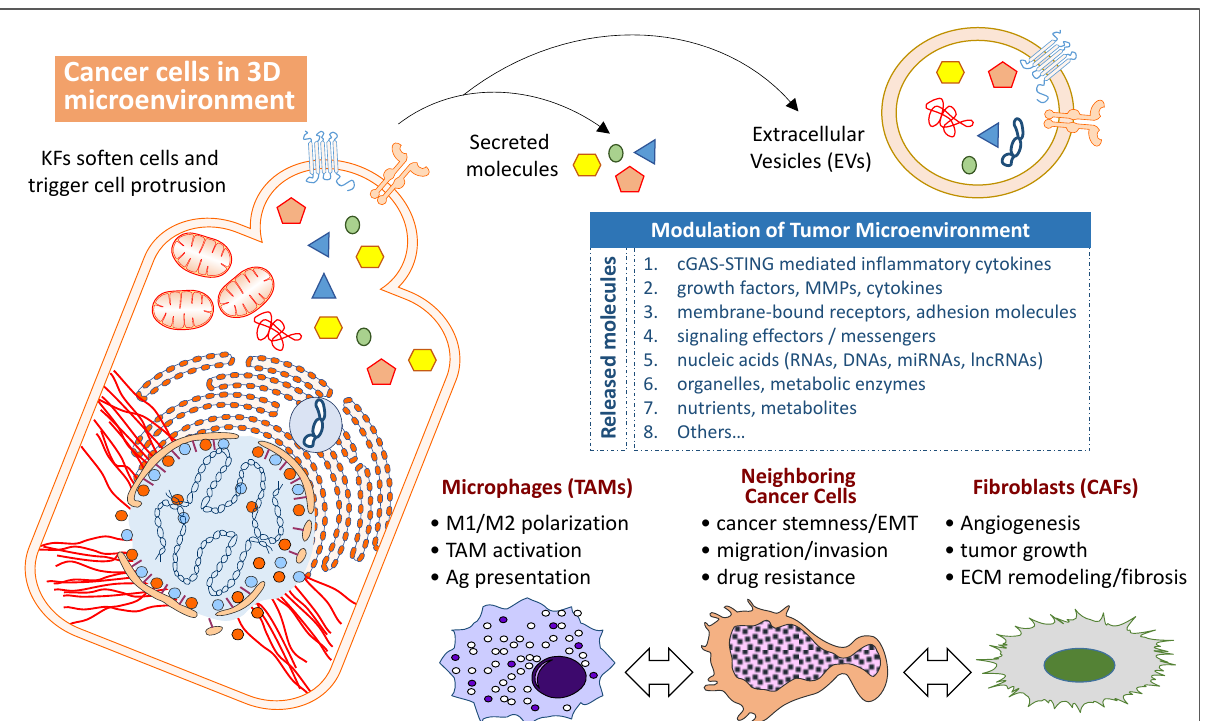
Figure 3. Modulation of the tumor microenvironment (TME) is associated with alterations of cytoskeleton networks. Cells with altered cytoskeleton network show softer mechanical properties and higher cancer stemness, which is associated with frequent membrane protrusion and extracellular vesicle (EV) release. When oxygen and nutrient gradients are present, the TME within the 3D lesions can be influenced by many factors and cells. The main remodeling factors, either released by direct secretion or embedded EVs, modulate cellular functions and behaviors of neighboring cancer cells, tumor-associated macrophages (TAMs), and cancer-associated fibroblasts (CAFs). In addition, altered cytoskeleton networks in cancer cells trigger DNA damage, leading to cGAS-STING activation and associated inflammation responses in cancer lesions.